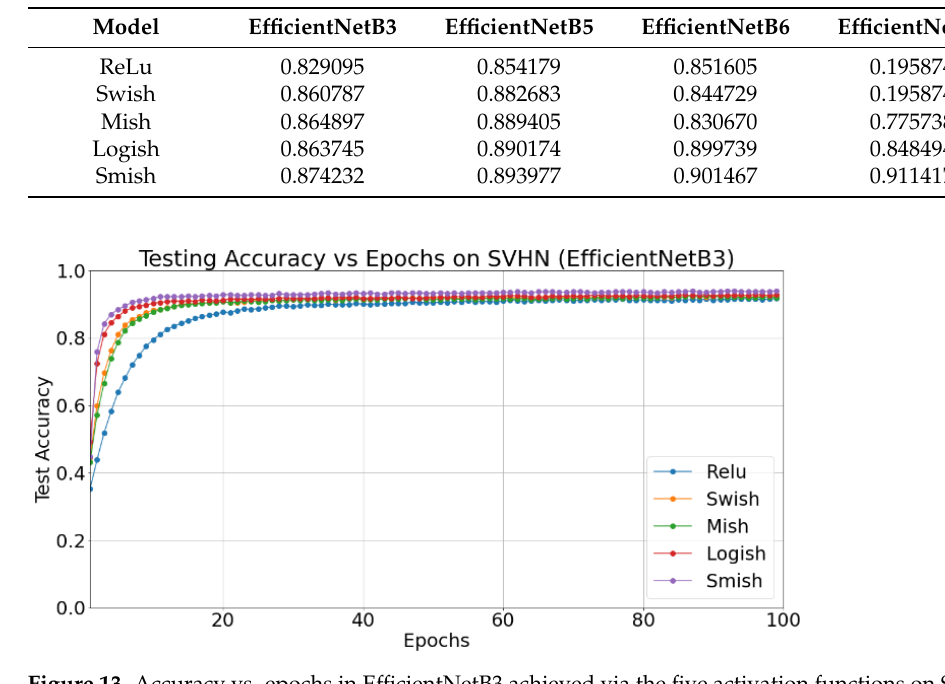
Table 4. Accuracy of EfficientNet models achieved via the five activation functions on SVHN.